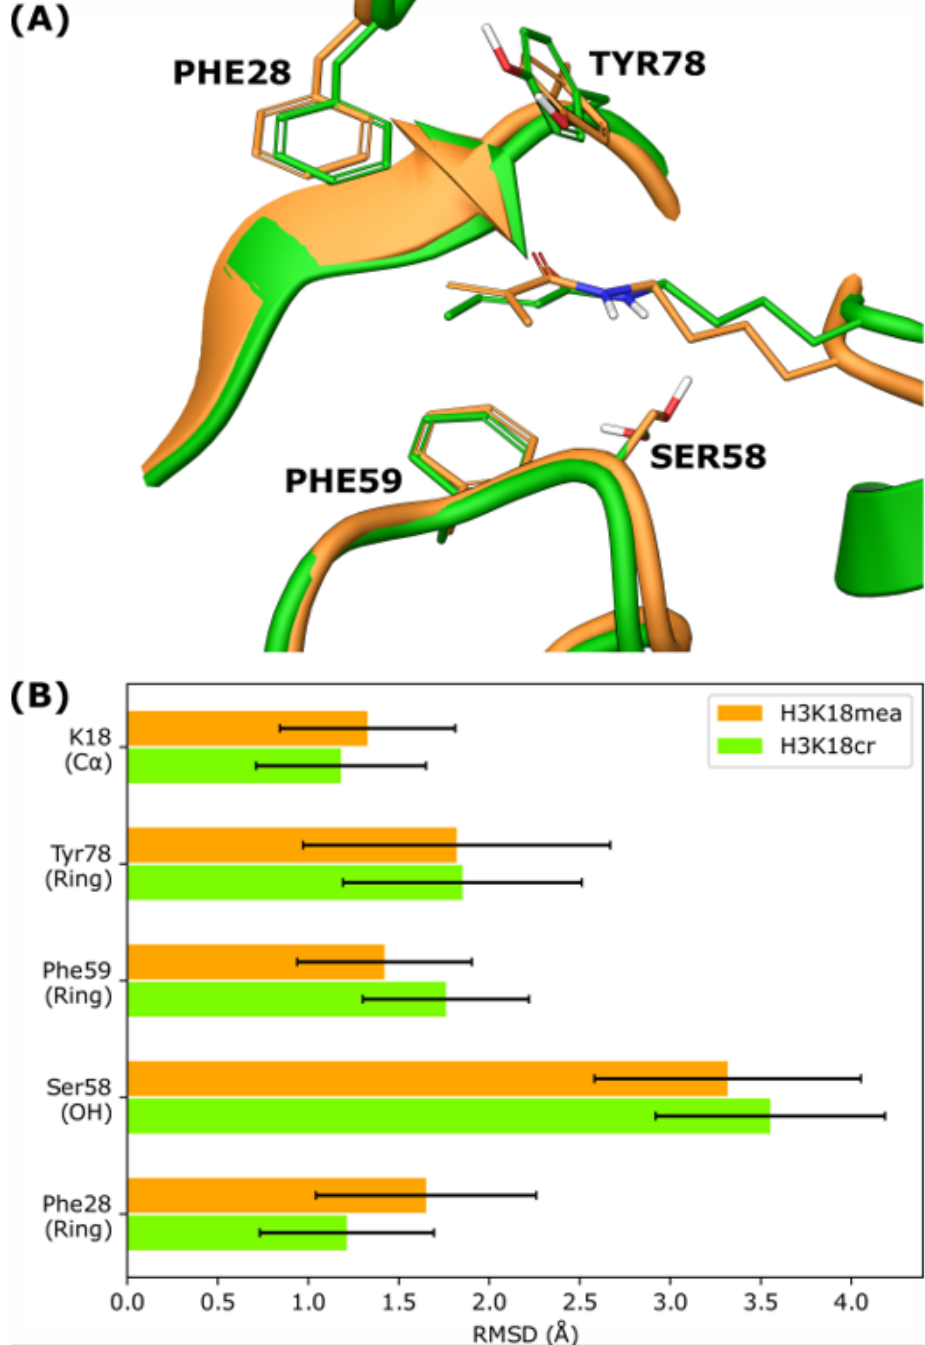
Figure 3. Molecular dynamics simulations. ( A ) Average structures of the AF9 YEATS methacryllysine/crotonyllysine binding site from the 500 ns MD simulations of H3K18mea (orange) and H3K18cr (green). ( B ) Root mean square deviations of selected atom groups compared to the starting H3K18cr structure.